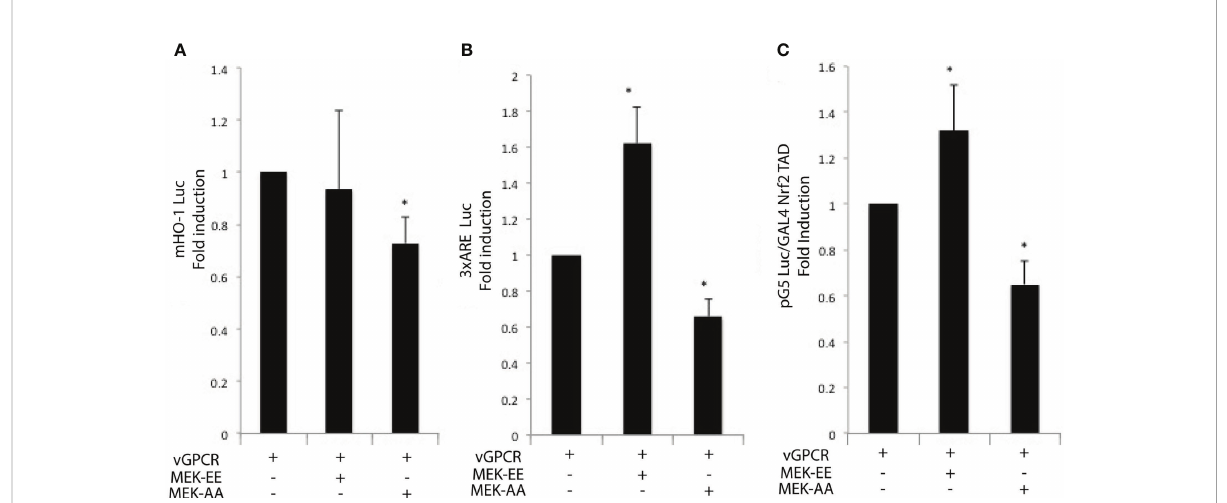
FIGURE 5 Luciferase activity of the murine HO-1 promoter (A) ; 3xARE Luc (B) and the GAL4 – Nrf2 TAD reporter system (C) of NIH3T3 cells after transfection of vGPCR alone (bar one in each set); co-transfection of vGPCR and MEK-EE (bar 2 in each set) and co-transfection of vGPCR and MEK-AA (bar three in each set). P-value < 0.05 (*).